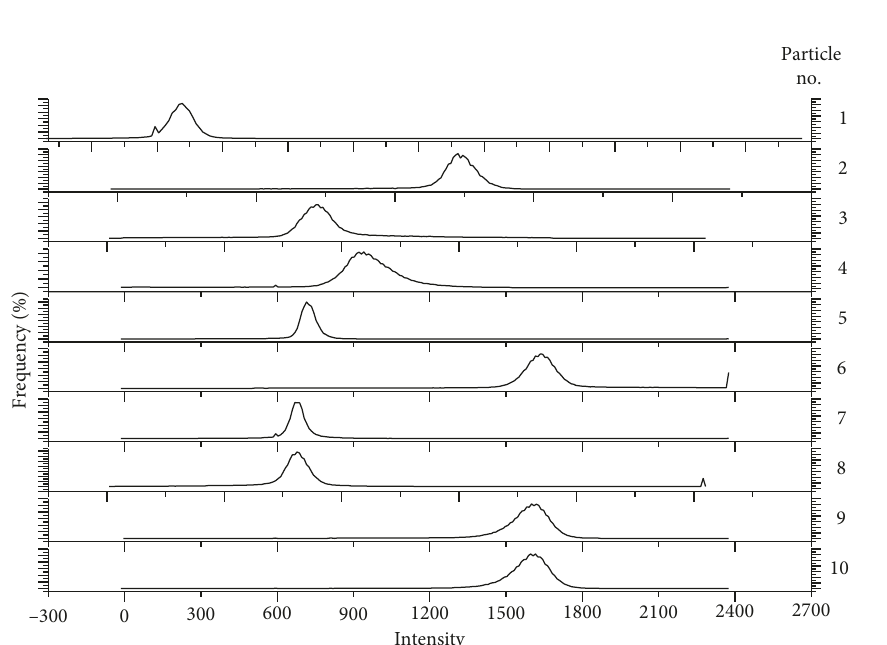
Figure 6: Intensity histograms of the randomly selected ten